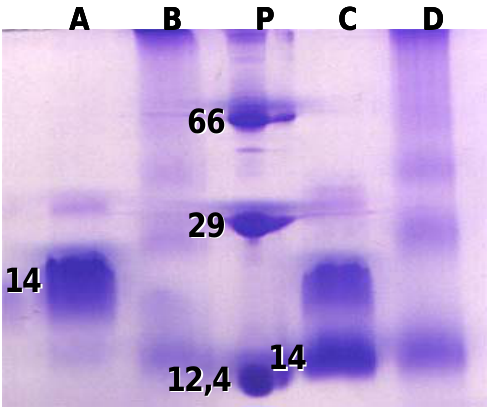
Figure 1. SDS-PAGE profile of bothropstoxin-1: ( A ) bothropstoxin-1 native and non- reduced; ( B ) bothropstoxin-1 irradiated and non-reduced; ( C ) bothropstoxin-1 native and reduced; ( D ) bothropstoxin-1 irradiated and reduced. P is the molecular weight